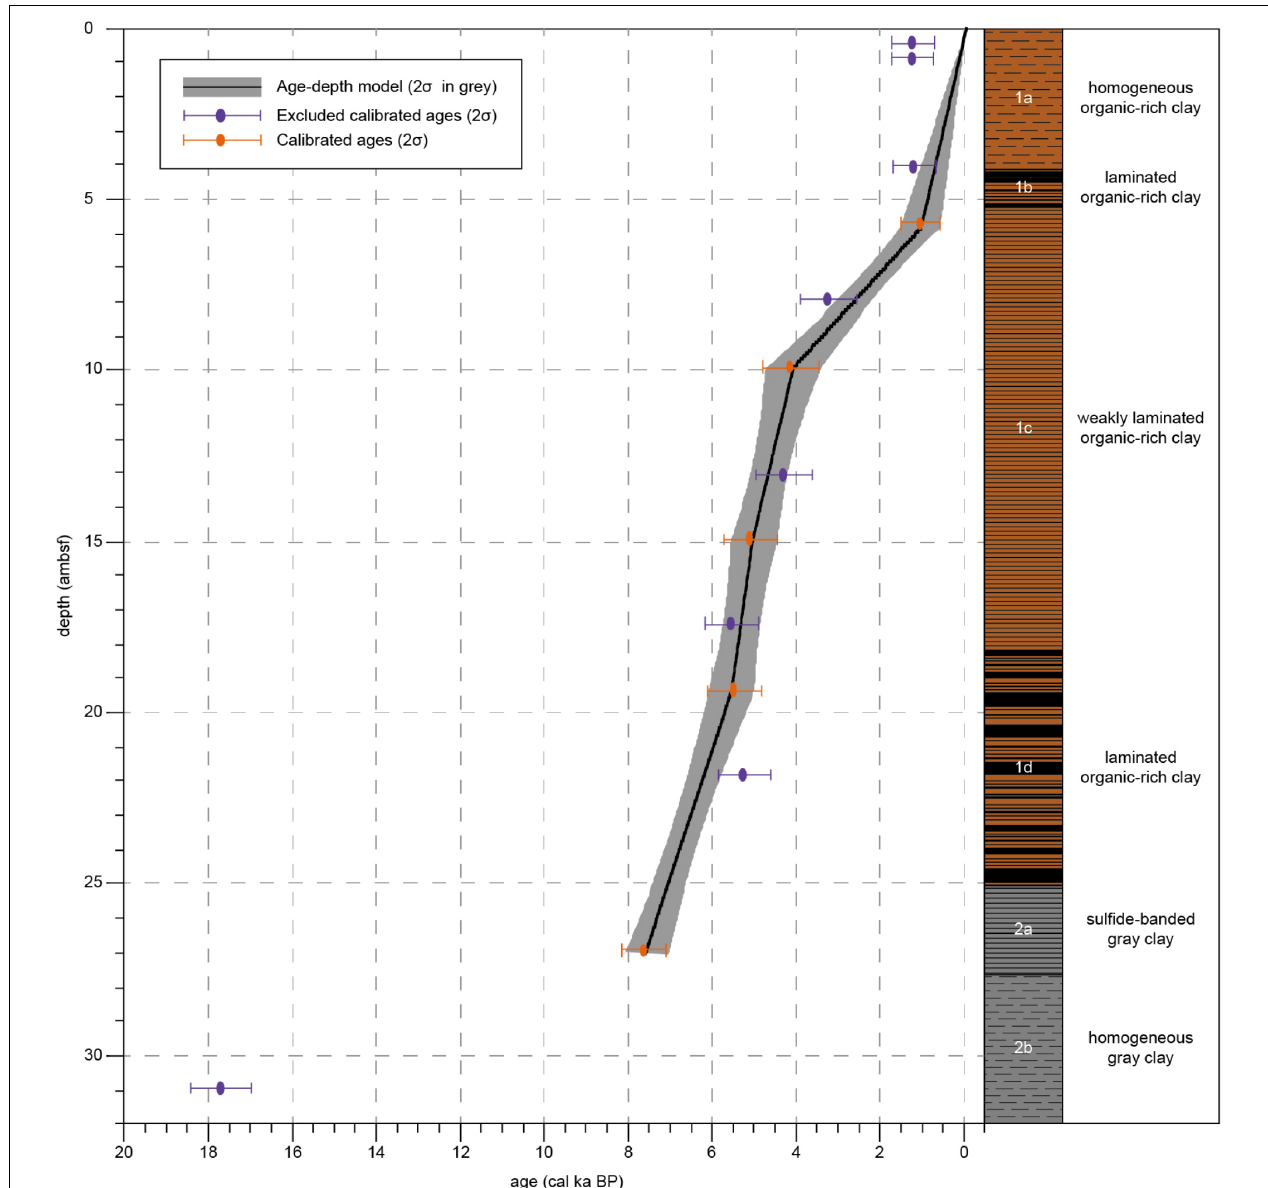
FIGURE 2 | Calibrated sample ages, age-depth model and lithology for Integrated Ocean Drilling Program Expedition 347 Core M0063D. Calibrated ages (2 σ ) of samples that have been excluded from the age-depth model are indicated in purple. Calibrated ages (2 σ ) of samples that have been used for the age-depth model are indicated in orange. The black line represents the age-depth model, the gray area represents 2 σ . Lithology and sedimentological units are obtained from Andrén et al.